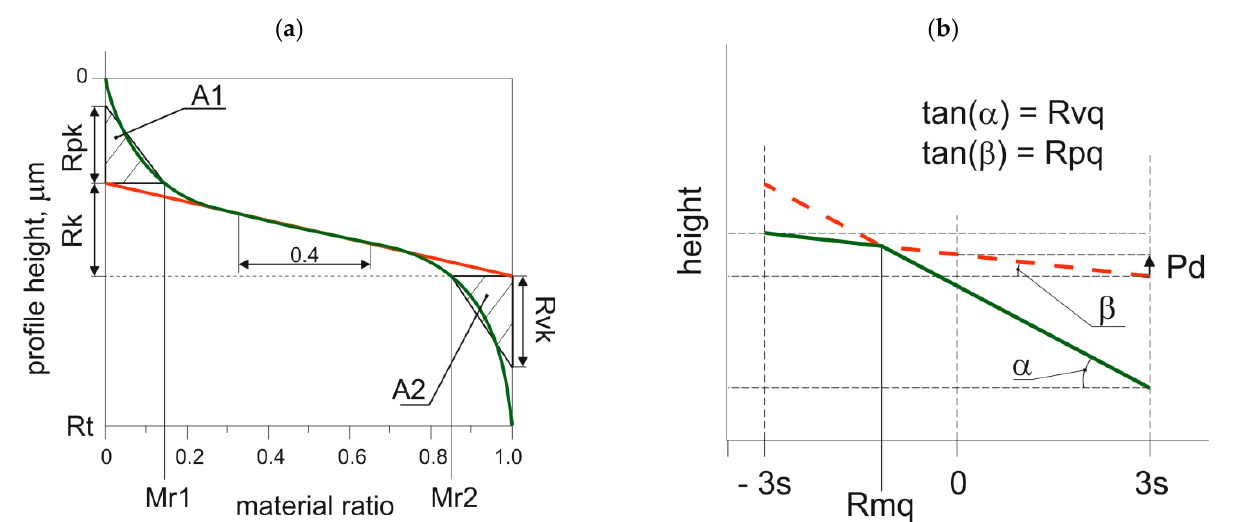
Figure 9. Graphical interpretation of parameters of the Rk family (ISO 13565-2 standard)—( a ) and from the Rq group (ISO 13565-3 standard)—( b ).